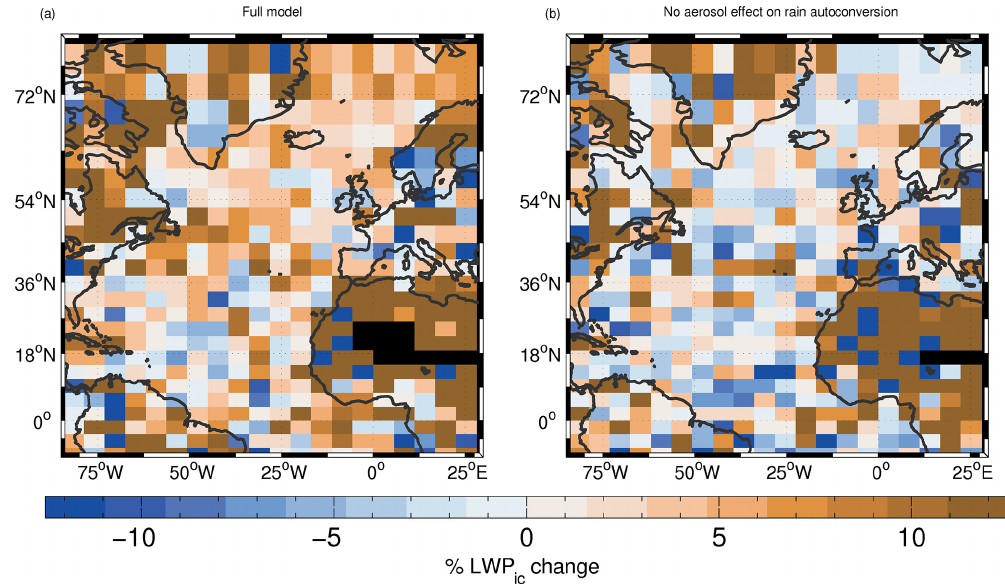
Figure E1. Mean percentage increase in LWP ic between PI and PD runs for (a) the full run and (b) the run where aerosol has been prevented from affecting the rain autoconversion.